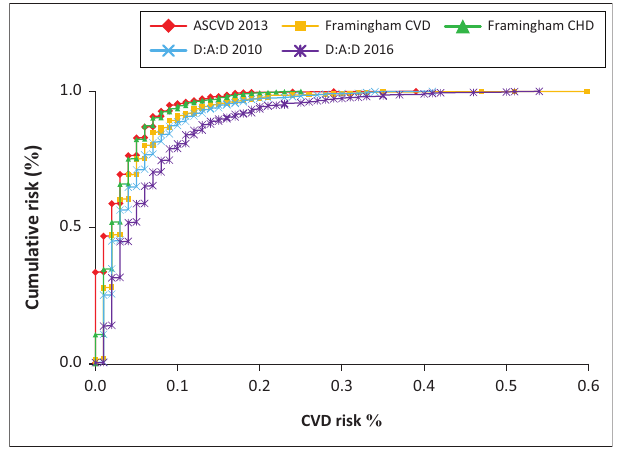
D:A:D Data Collection on Adverse Events of Anti-HIV Drugs; ASCVD, Atherosclerotic Cardiovascular Disease Risk Score; CHD, Coronary heart disease; CVD, Cardiovascular disease. FIGURE 2: Cumulative risk for all Ndlovu Cohort Study HIV-positive study participants for the cardiovascular disease risk prediction